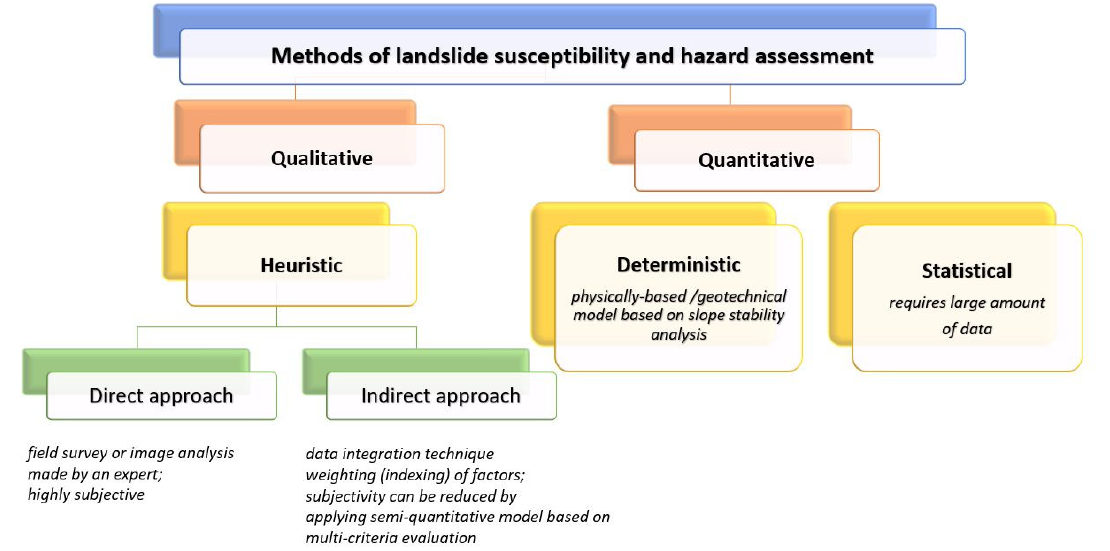
Figure 2. Scheme of the classification of the methods of landslide susceptibility assessment derived from Barredo et al. [22] and Hervás and Bobrowsky [6].